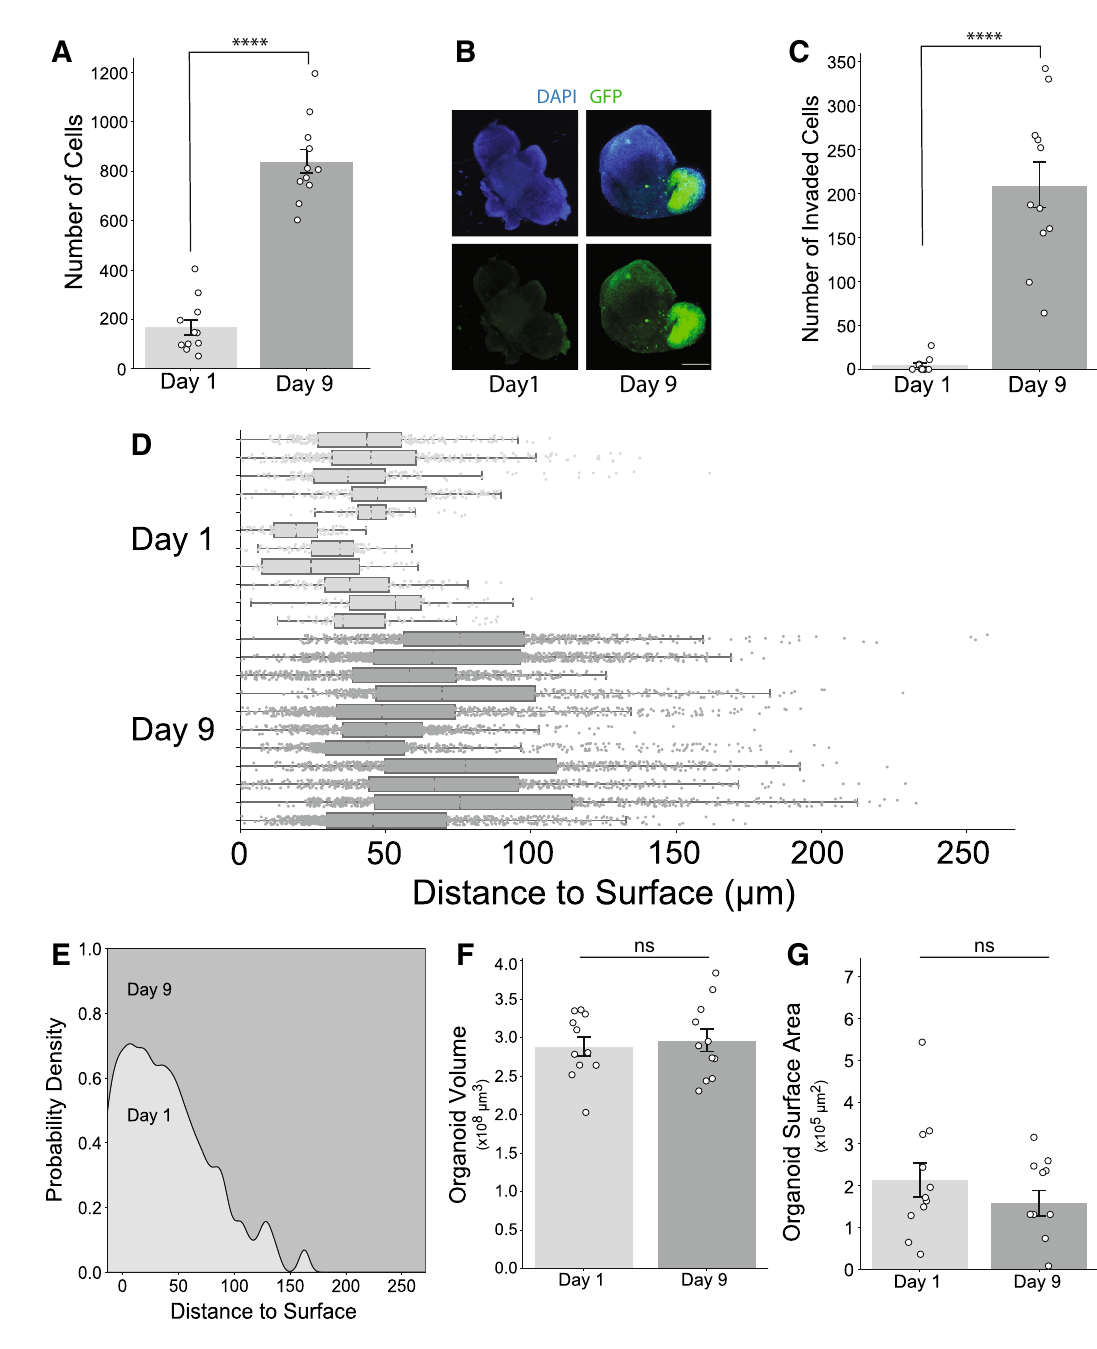
Figure 2. GBM cells proliferate and invade in a cerebral brain organoid-GBM co-culture model. ( A ) Total number of GBM cells at 1 and 9 days post co-culture; combined from three experimental replicates. ( B ) Representative maximum intensity projection images of fDISCO cleared cerebral brain organoid-GBM co-cultures. Top row: GFP-expressing GBM cells; bottom row: GFP merged with DAPI; scale bar for all images is in bottom right image and represents 300 µm. ( C ) Number of cells whose distance to the surface of the organoid exceeded the invasion threshold defined as the average third quartile value of the Day 9 group. ( D ) GBM cell distance to the nearest organoid surface. Boxplots represent individual organoids; data points are individual GBM cells. Distance was normalized by setting the minimum distance for each organoid to 0. ( E ) Normalized stacked kernel density estimation (KDE) of GBM cell distance to organoid surface. ( F , G ) Organoid volume (F) and surface area (G) measured using Imaris software. Statistical comparisons performed using an unpaired, two-tailed t test; **** ≤ 0.0001. Data from three independent biological